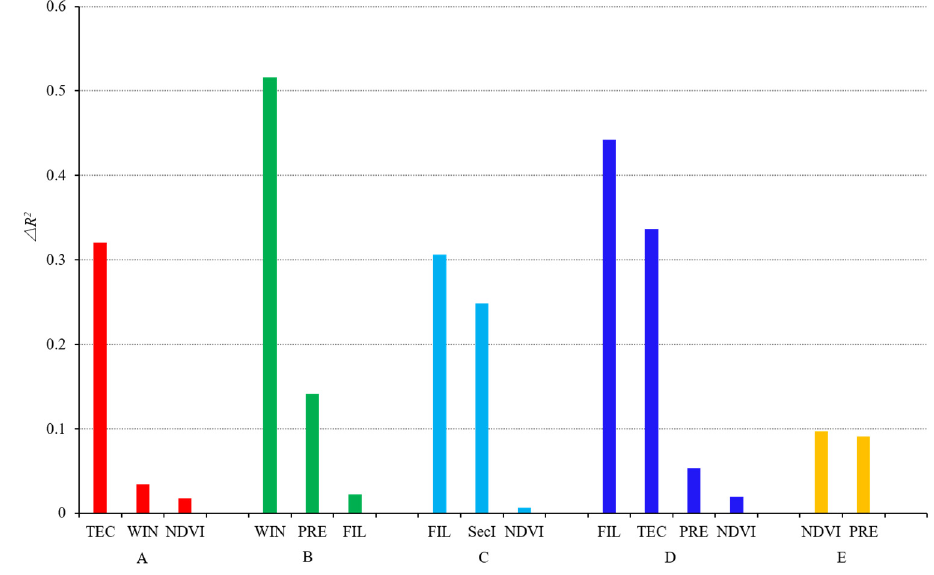
Figure 6. Ranking of the importance of influencing factors associated with significant spatial heterogeneity in typical regions: region A: the northeastern region; region B: the Central Plains; region C: the Sichuan Basin; region D: the Yunnan-Guizhou Plateau (most of the cities are located in Yunnan); region E: the lower reaches of the Yangtze River.